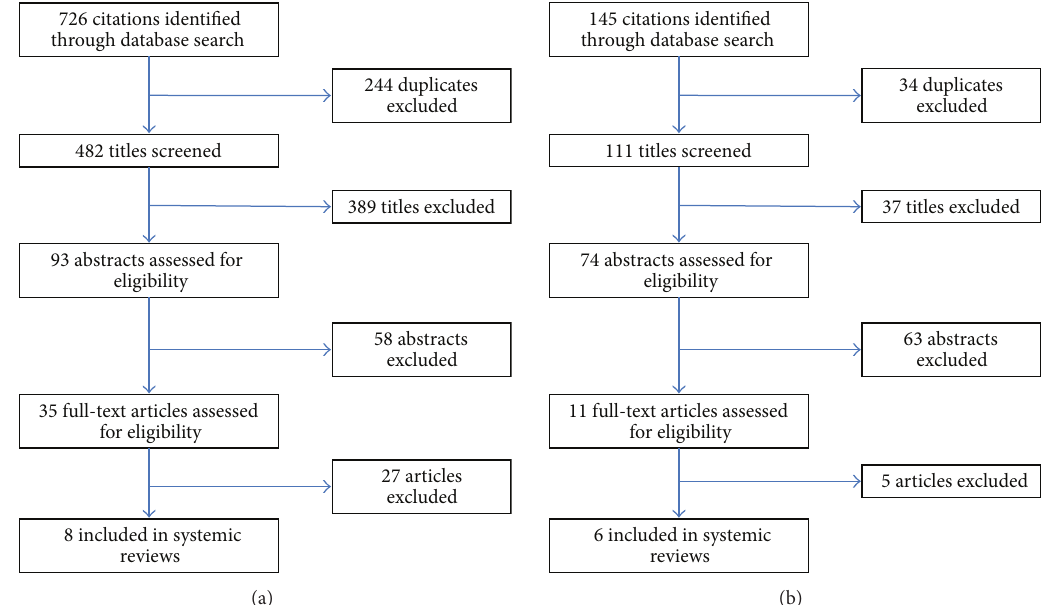
Figure 1: Flow charts showing selection of articles for systematic review. (a) Laparoscopic lateral transperitoneal adrenalectomy versus posterior retroperitoneoscopic adrenalectomy. (b) Laparoscopic adrenalectomy versus robotic